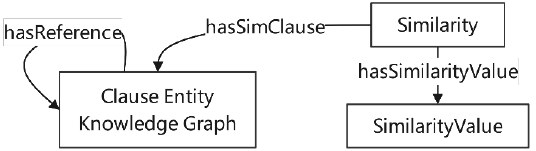
Figure 16. Basic structure of the code knowledge graph.